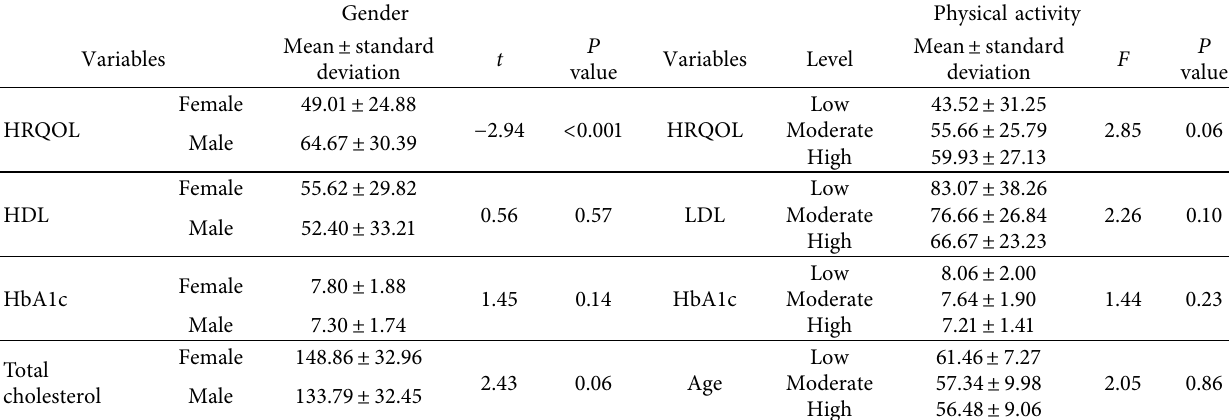
Table 4: Te relationship between gender and physical activity with level of HRQOL and metabolic indicators ( n � 135).